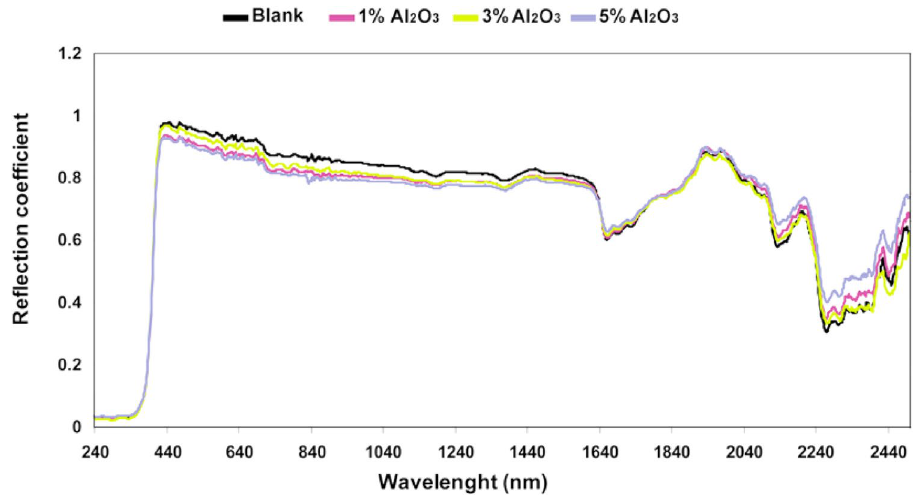
Figure 4. Absolute reflection coefficient of samples of nanocomposite coating for 0, 1, 3, and 5% of aluminum oxide nanoparticles in (UV/VIS/NIR)